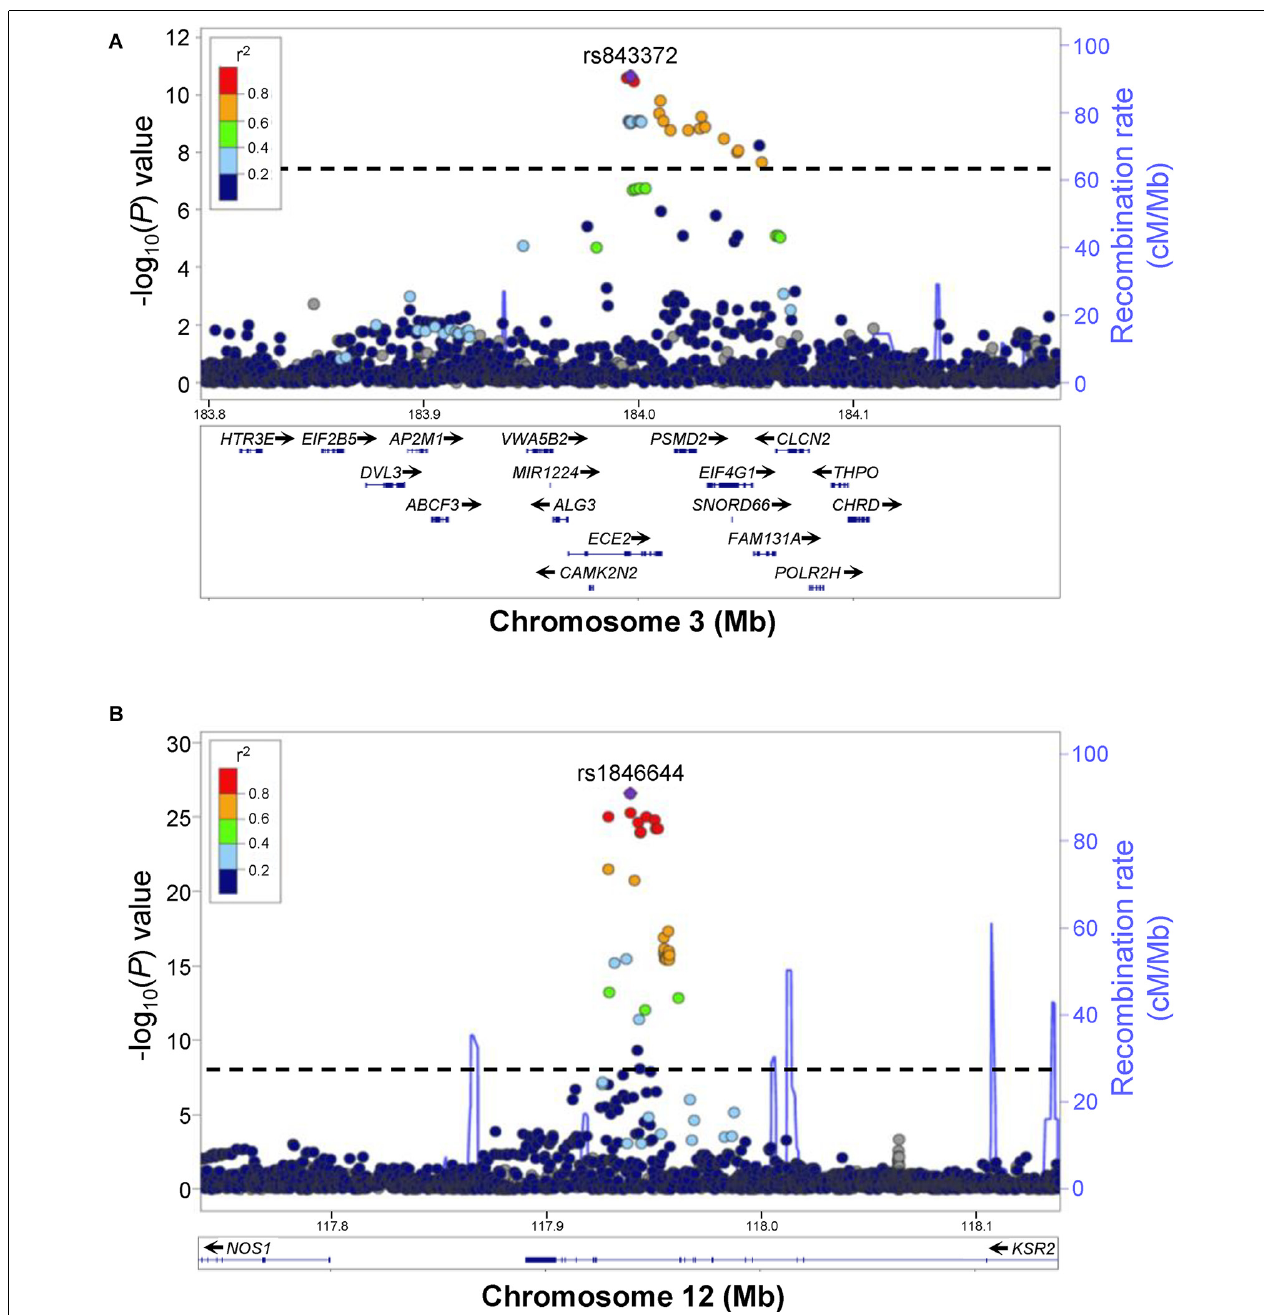
FIGURE 1 | Examples of human GWAS data for excessive daytime sleepiness (EDS). Regional association plots for genome-wide significant associations for rs843372 (A) and rs1846644 (B) with EDS are shown. Genes within each region are shown in the lower panels. Blue lines indicate recombination rate. Filled circles show the − log 10 P-value for each SNP, with the named SNP shown in purple. Additional SNPs are colored according to correlation (r 2 ) with the lead SNP, estimated by LocusZoom based on the CEU HapMap haplotypes. Dashed black lines indicate the genome-wide significance threshold ( P < 5 × 10 -8 ). (A) rs843372 and nearby SNPs that have a genome-wide significant association with EDS are spread out over several different genes, making it difficult to predict which gene is associated with EDS. (B) rs1846644 and nearby SNPs that have a genome-wide significant association with EDS are located within introns of the KSR2 gene locus, suggesting that variation in KSR2 might be associated with EDS. Reproduced and modified from Lee et al. (2019).